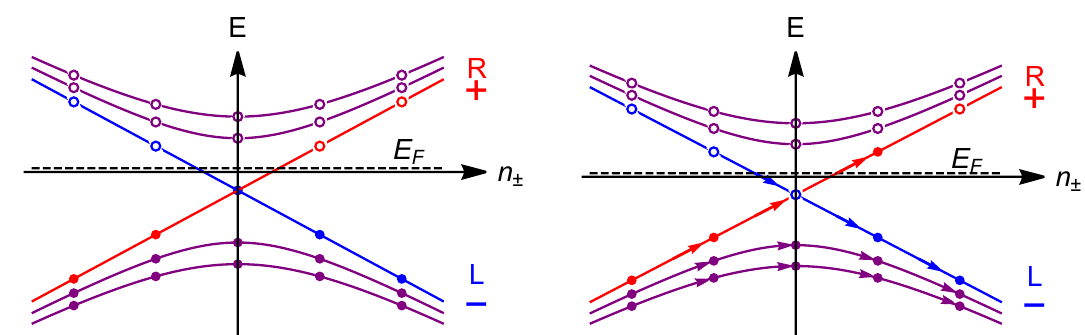
Figure 12: Left panel: Energy spectrum of the 3 d infinite hotel with ground state filling. Right panel: Filling after insertion of one flux quantum with spectral flow shown by